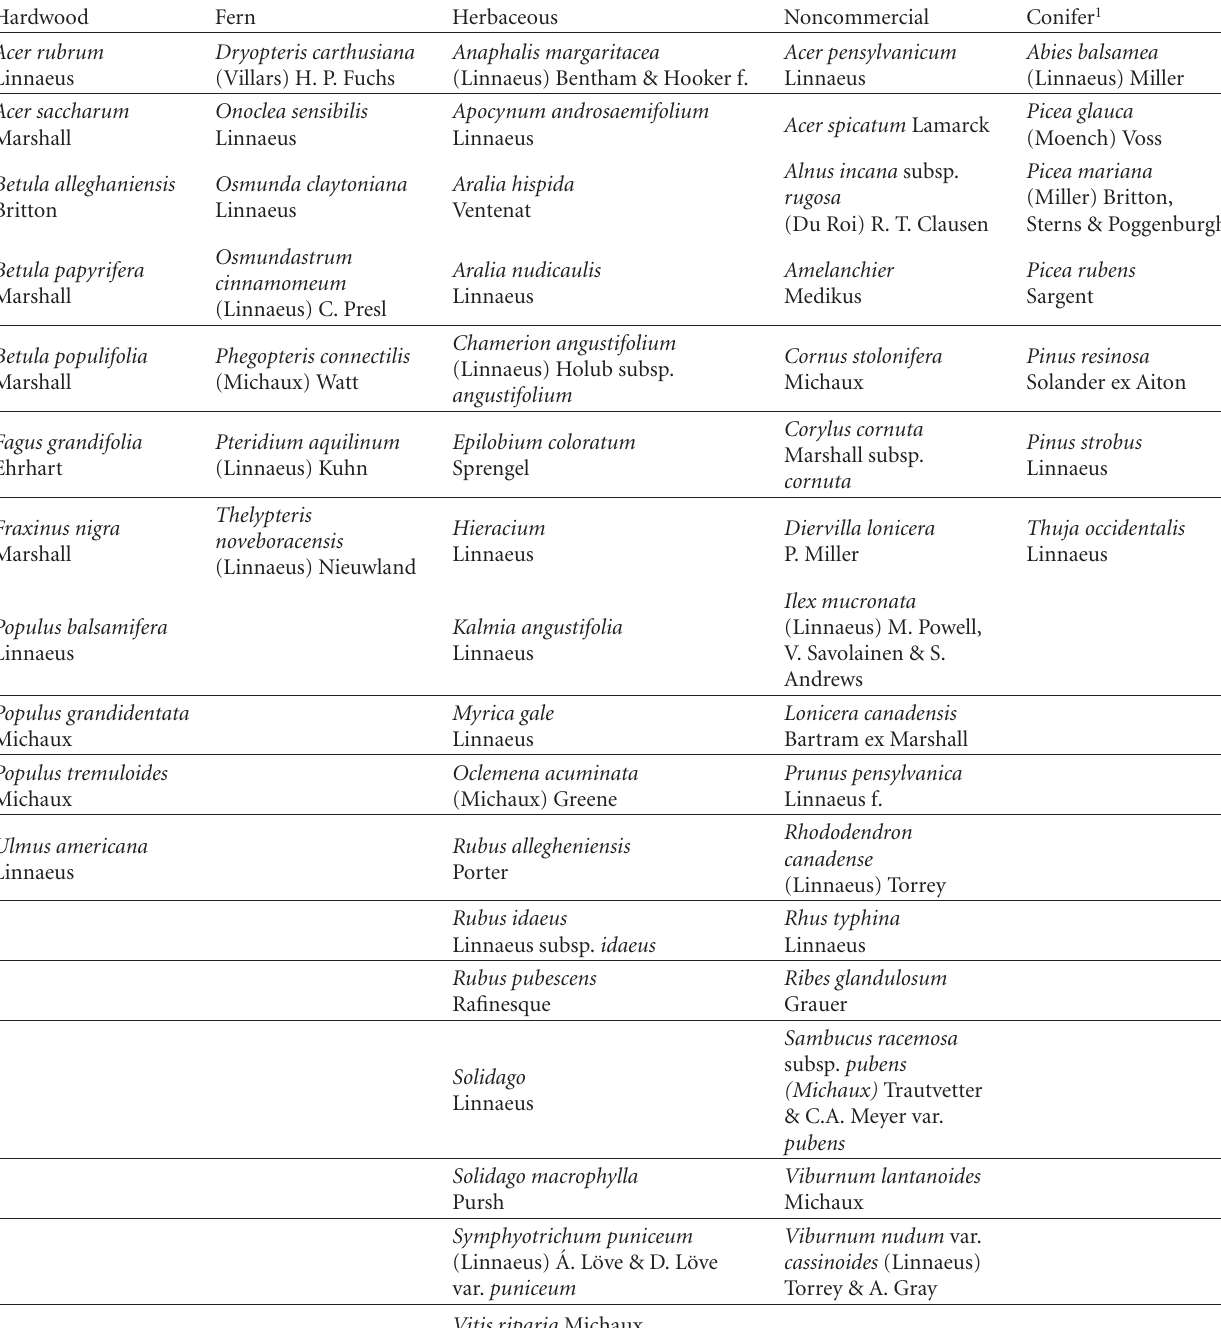
Table 1: Plant species included in each vegetation group. Plant names were reviewed according to VASCAN (http://data.canadensys.net/vas- can/search/), the Database of Vascular Plants of